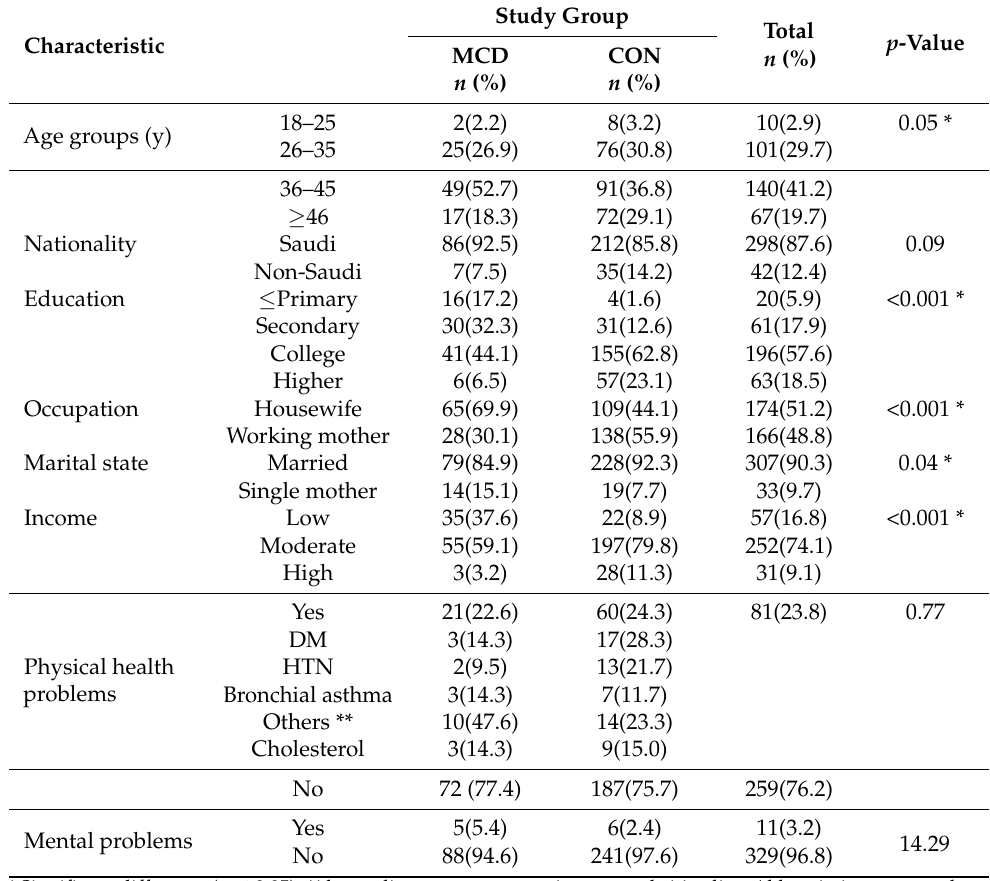
Table 1. Sociodemographic characteristics and health status of the